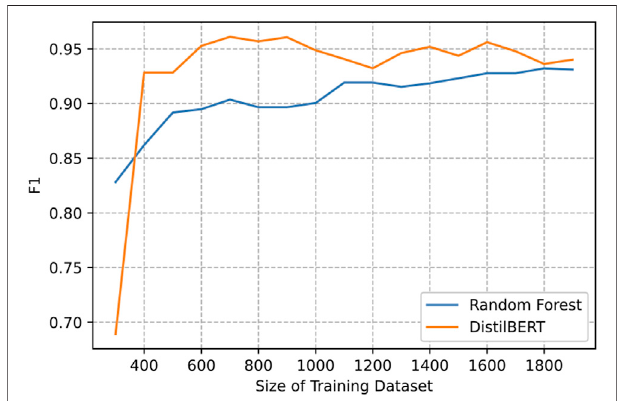
FIGURE4| Learningcurveoftestperformancewithincreasingamounts of training